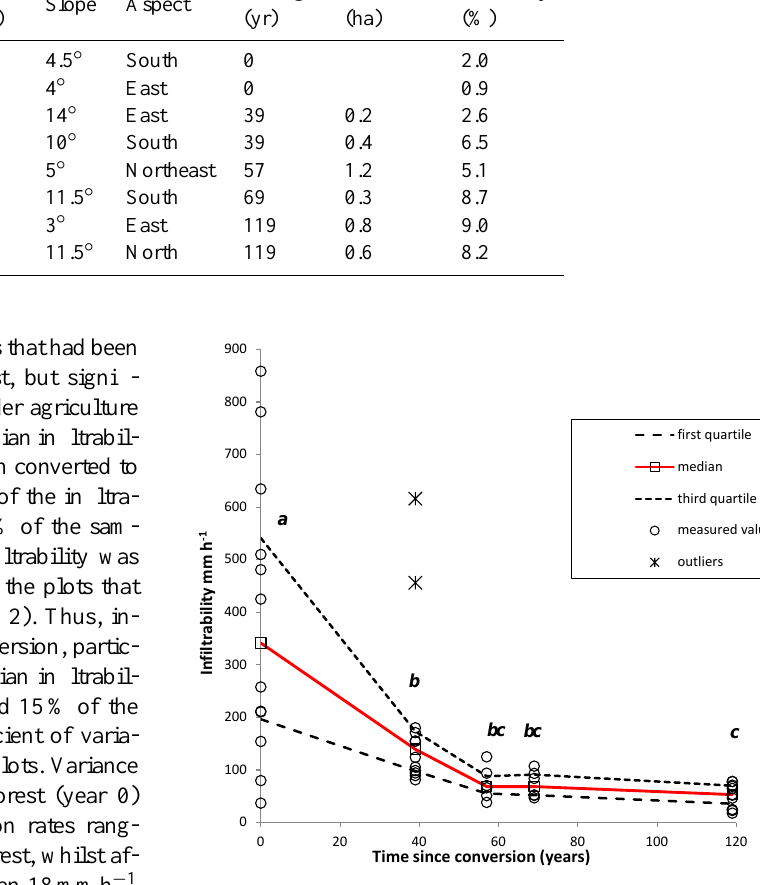
Fig. 2. Infiltrability rates for the plots along the chronosequence as Figure 2. Infiltrability rates for the plots along the chronosequence as a function of years since a function of years since conversion to agriculture. Letters in ital- conversion to agriculture. Letters in italics represents significance. Years since conversion not ics represent significance. Years since conversion not followed by followed by the same letter are significantly different (p<0.05, Mood Median test). the same letter are significantly different ( p < 0.05, Mood’s median